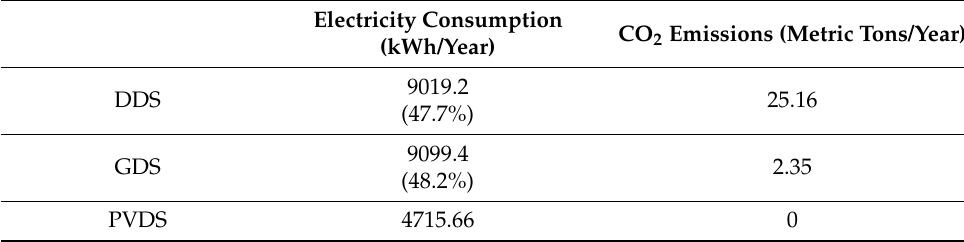
Table 2. Values of yearly electricity consumption and CO 2 emissions estimated for the three systems under study. Values between parenthesis are the savings in terms of electricity consumption if a PVDS was used instead of a DDS or